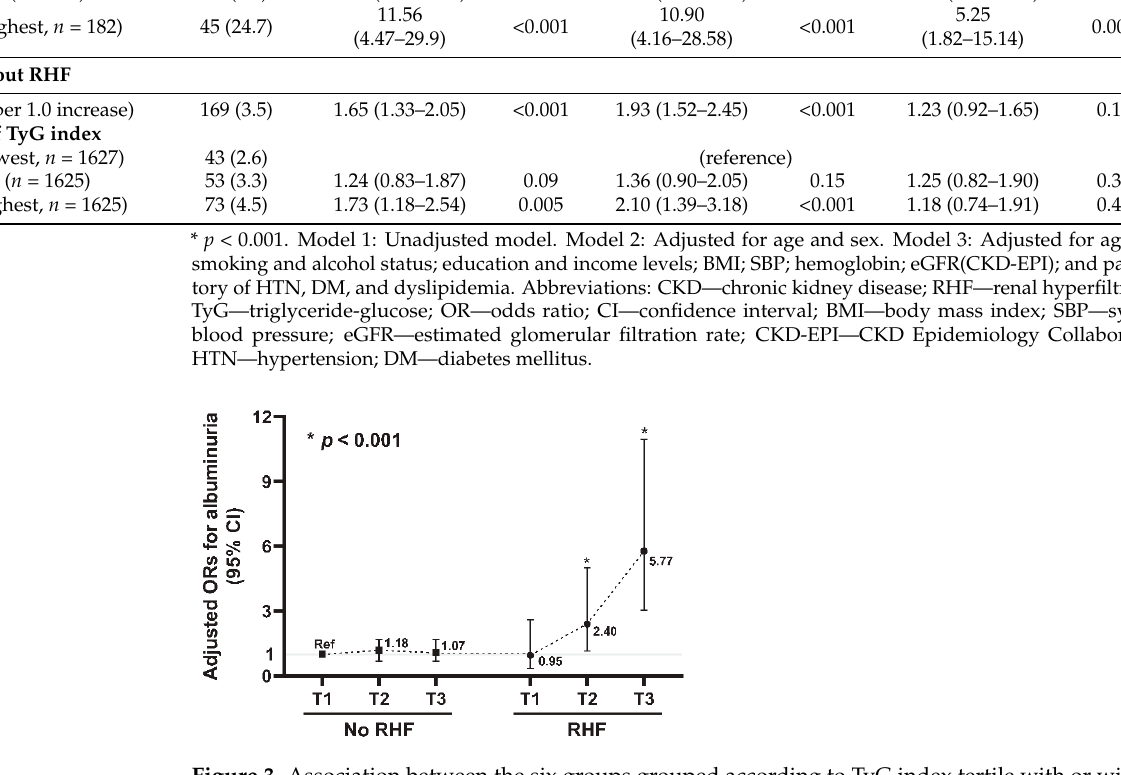
Figure 3. Association between the six groups grouped according to TyG index tertile with or without RHF and albuminuria. Each number indicates ORs for albuminuria and the error bars represent 95% CIs. Abbreviations: TyG index—triglyceride glucose index; RHF—renal hyperfiltration; OR—odds ratio; CI—confidence Table 5. Subgroup analysis stratified by the combination of RHF and TyG index.